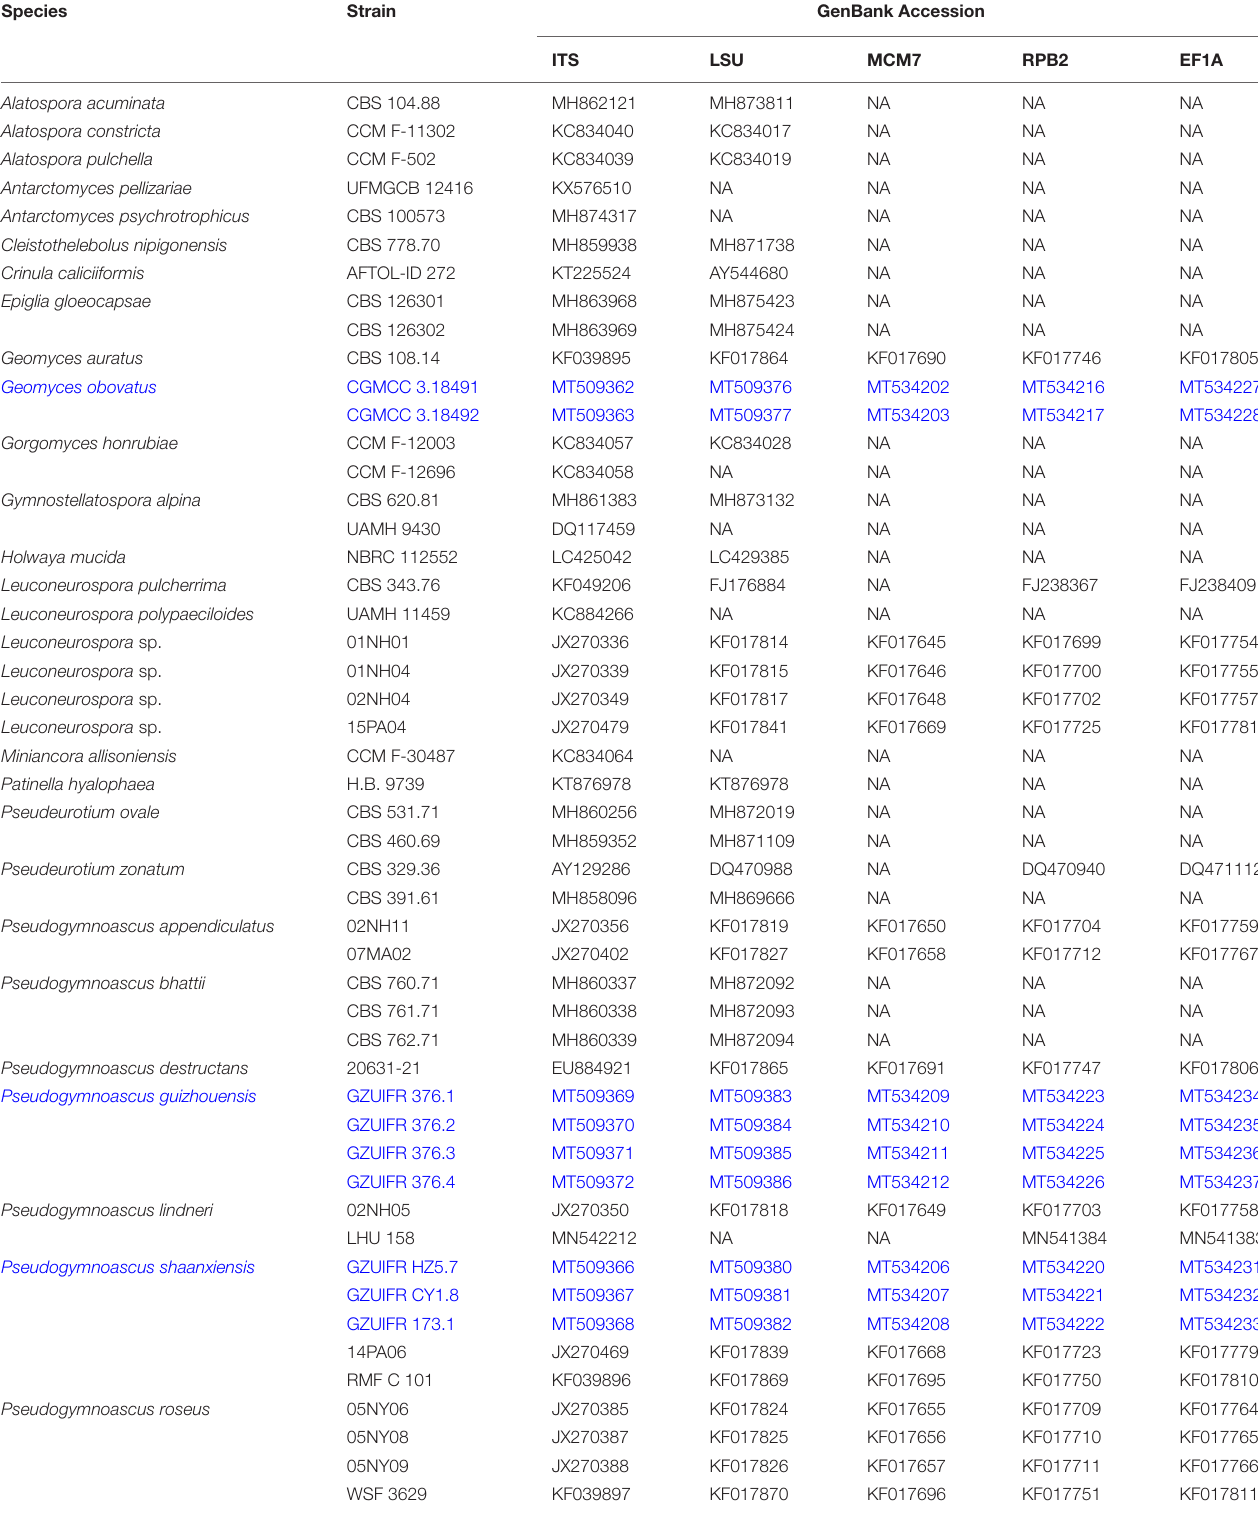
TABLE 1 | List of strains used in the phylogenetic